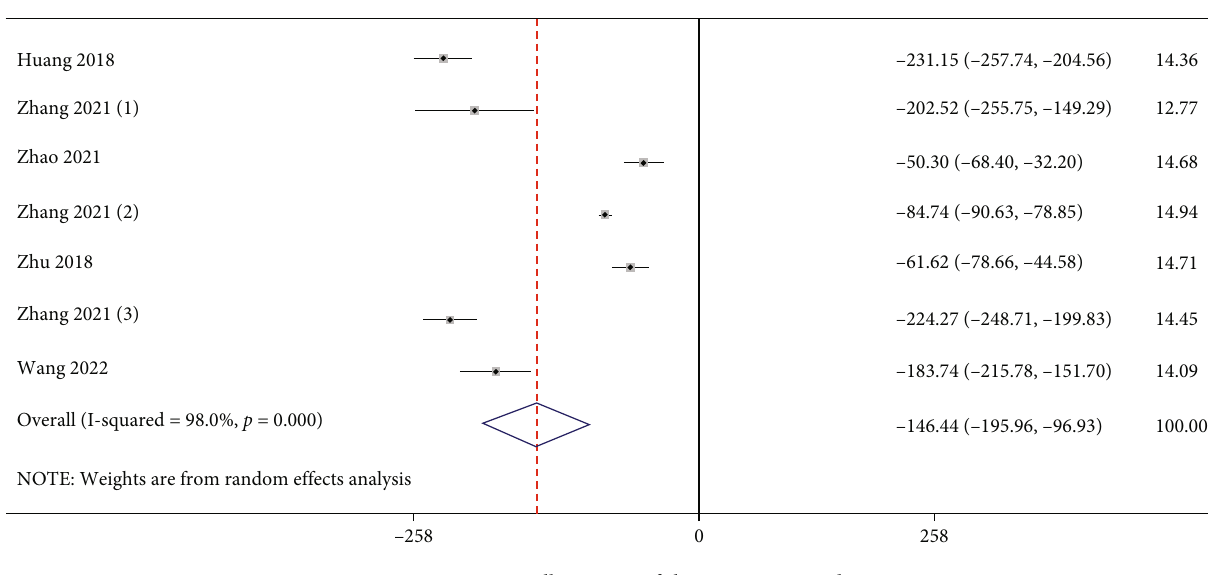
Figure 2: Forest illustration of the serum uric acid.